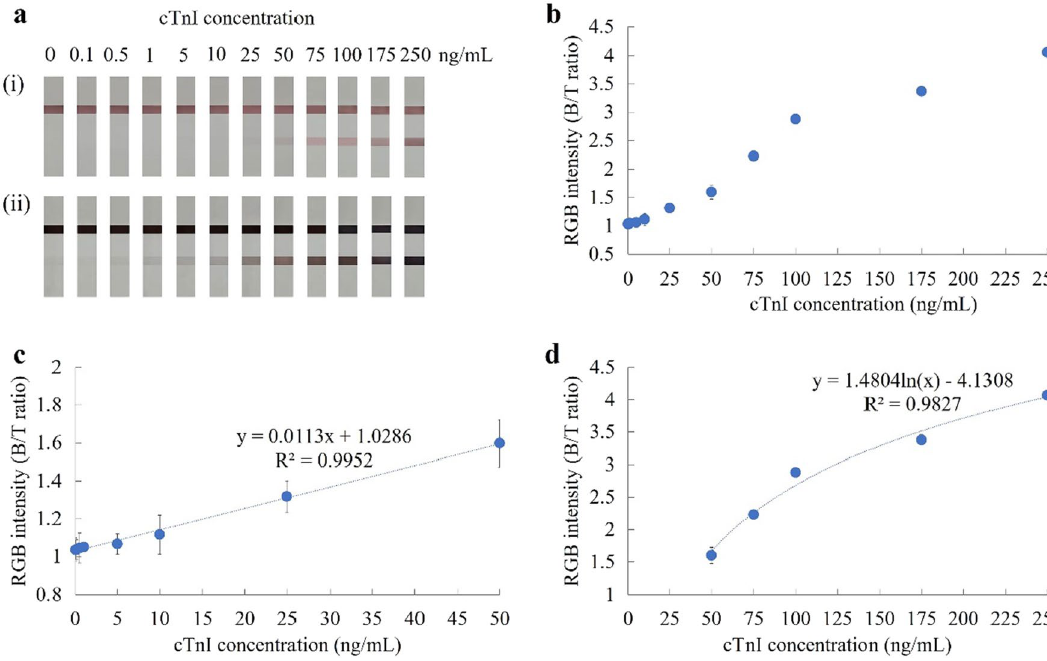
Figure 5. ( a ) Images of cTnI detected across concentrations of 0–250 ng/mL (i) before, and (ii) after silver enhancement. ( b ) Plot of RGB intensity (B/T ratio) versus concentration of cTnI as interpreted by smartphone with RGB color picker application. ( c ) Calibration curve of cTnI concentration in the range of 0–50 ng/mL. ( d ) Calibration curve of cTnI concentration in the range of 50–250